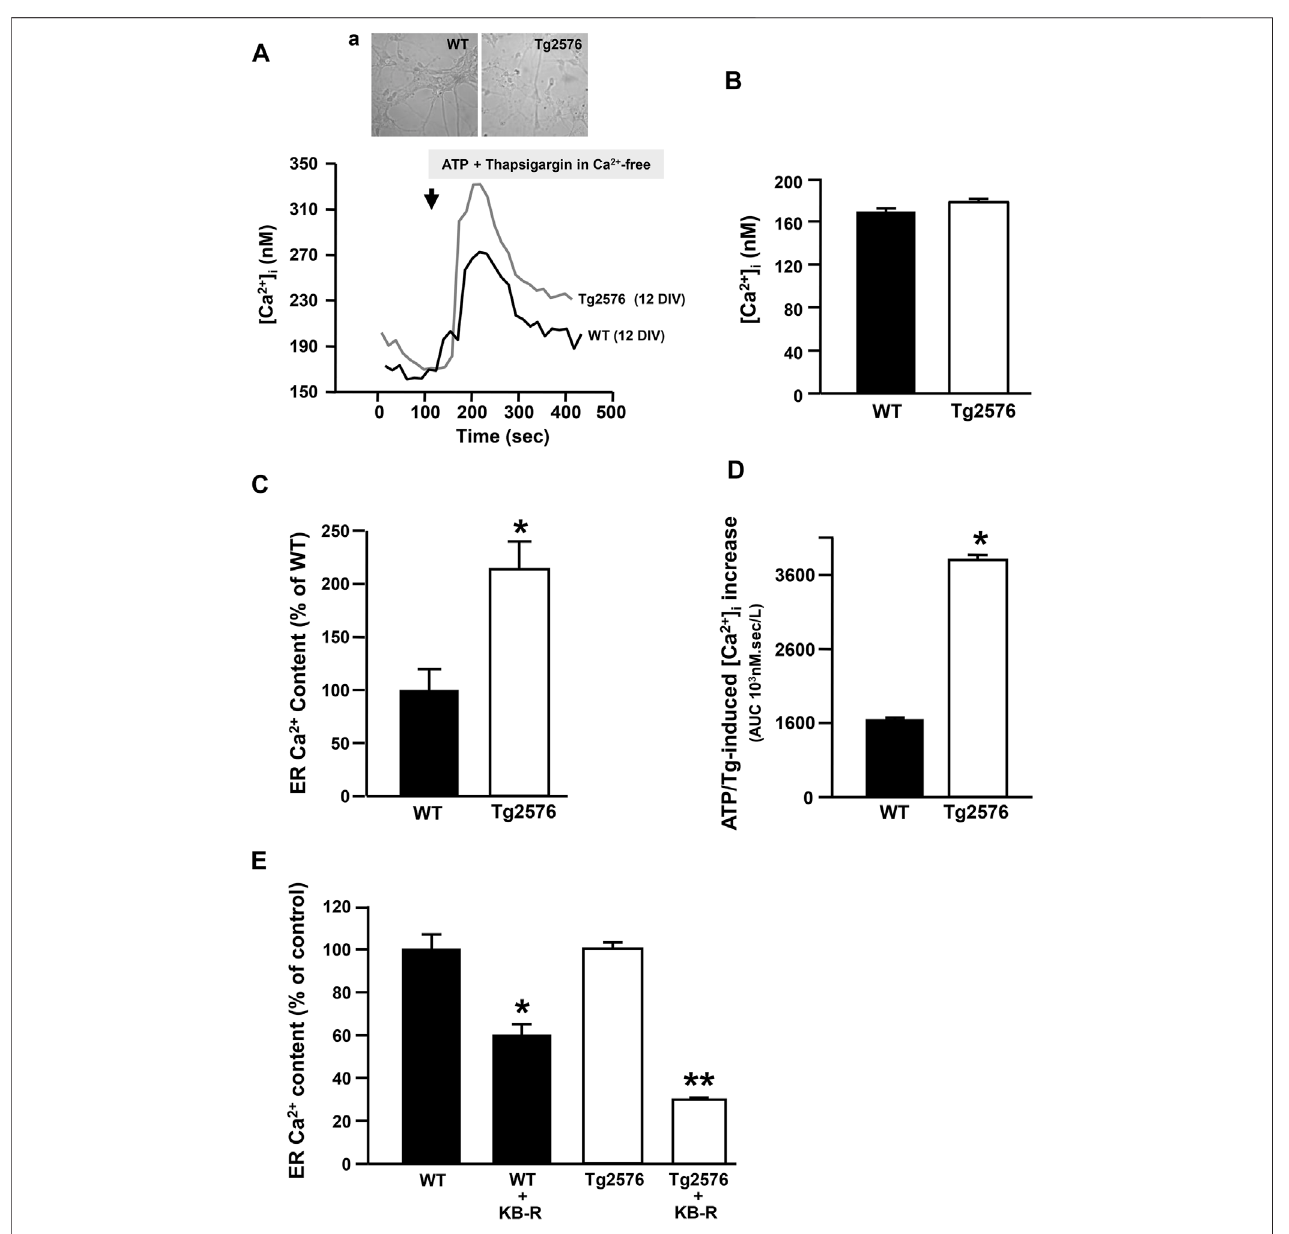
FIGURE3| EffectofNCX3inhibitionbyKB-R7943onERCa 2+ contentinWTandTg2576primaryhippocampalneurons. (A) Representativesuperimposedtraces of [Ca 2+ ] i measured in WT (black trace, N (cid:2) 36) and Tg2576 (grey trace, N (cid:2) 34) primary hippocampal neurons at 12 DIV, representative images in panel (A) . (B) Quanti fi cation of basal values of [Ca 2+ ] i in WT ( N (cid:2) 36) and Tg2576 primary hippocampal neurons at 12 DIV ( N (cid:2) 34). (C) ER Ca 2+ content quanti fi ed as [Ca 2+ ] i increase inducedbyThapsigargin(Tg;1 μ M)andATP(100 μ M)in0 μ MCa 2+ ,andexpressedaspercentageoftheeffectobservedinWT(consideredas100%). (D) AUCsof [Ca 2+ ] i calculated for (A) . (E) Quanti fi cation ofER Ca 2+ content inWT and Tg2576 primary hippocampalneurons at 12DIV treated with KB-R7943 at 0.5 μ M. Values are represented as percentage of respective controls, expressed as mean ± SEM of 3 independent experimental sessions. Statistical comparisons between groups were performed by one-way ANOVA followed by Newman-Keuls ’ test. (* p < 0.05 vs. WT; ** p < 0.05 vs. Tg2576 mice).